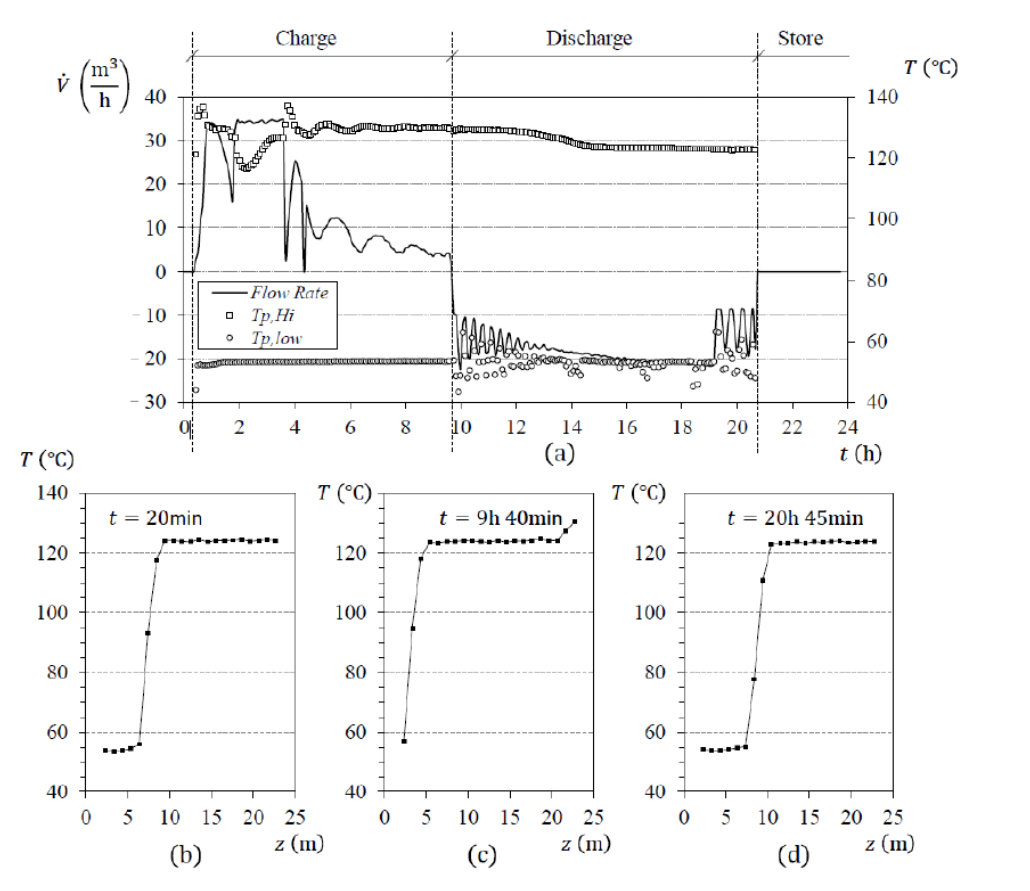
Figure 3. ( a ) Flow rate and pipe temperatures in a 24 h period with charging, discharging and storing periods; Temperature profiles at: ( b ) the beginning of charge; ( c ) after the charge and ( d ) after the discharge